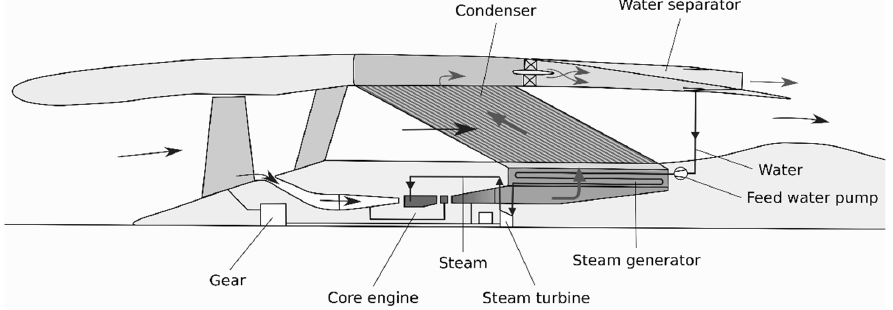
Figure 3. Schematic of the resulting WET configuration with reduced complexity and full nacelle integration.